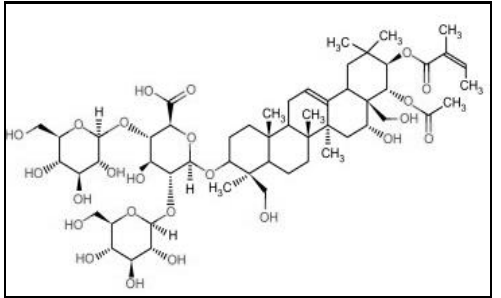
Figure 9. Chemical structure of escin (81)